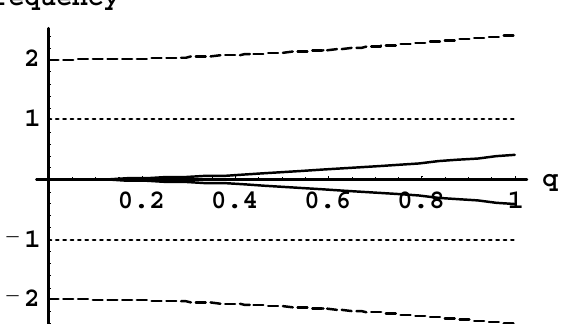
Figure 23. Central frequencies of the Ly-alpha line components versus the parameter q (given by Equations (12.15 and (12.16). Components at the central frequencies ±[(1 + q 2 ) 1/2 − 1], ±[(1 + q 2 ) 1/2 + 1], and ± 1 are shown by solid, dashed, and dotted lines, respectively. The frequency of the 0-component coincides with the abscissa axis. The central frequency is defined as the frequency, at which the component has the primary maximum of the intensity for the zero eccentricity of the orbit of the outer, Rydberg electron. The frequencies are in units of the Kepler frequency Ω of the outer electron ( given by Equation (12.3)) and they are counted from the unperturbed frequency of the spectral line [150]. Figure 24 presents the relative intensities of the Ly-alpha line components versus the parameter q, as follows. Intensities of the components having the central frequencies ±[(1 + q 2 ) 1/2 − 1], ±[(1 + q 2 ) 1/2 + 1], ±1, and 0 are shown by solid, dashed, dotted, and dash-dotted lines, respectively.